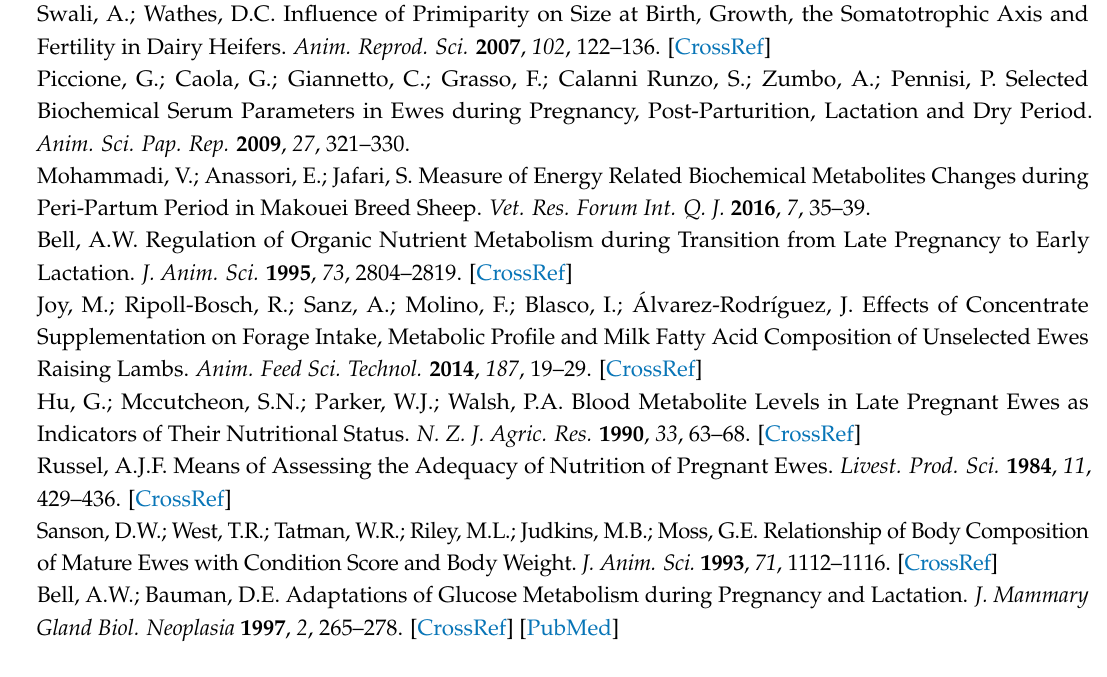
Figure S7 : Concentrations of non-esterified fatty acids (NEFA) in plasma (mmol/l) in all ewes (left panels column, a, d, g, and j), mature ewes (central panels column, b, e, h, and k), and maiden sheep (right panels column, c, f, i, and l) throughout the study period. Sheep were classified by pregnancy rank (single: ; multiple: (cid:3) ; top row of panels a, b, and c) and by level of BCS measured at mid-pregnancy (BCS-1, second row of panels d, e, and f), at late (cid:35) pregnancy (BCS-2; third row of panels g, h, and i), and postpartum (BCS-3; bottom row of panels j, k, and l). BCS levels were “Thin” ( (cid:72) ) for sheep with a BCS ≤ 2, “Average” ( (cid:7) ) for sheep with 2 < BCS < 3, and “Fat” ( (cid:78) ) for sheep with a BCS ≥ 3. Data are mean ± S.E.M. When significant, the interactions of time × pregnancy rank or time × BCS level are represented in each panel by an upper horizontal line and capital letters indicating significance level (A: p < 0.0001; B: p < 0.001; b: tendency). Asterisks indicate significant differences between groups at each time point (**** p < 0.0001; *** p < 0.001; ** p < 0.01; * p < 0.05). Figure S8 : Plasma urea concentration (mg/dl) in all ewes (left panels column, a, d, g, and j), mature ewes (central panels column, b, e, h, and k), and maiden sheep (right panels column, c, f, i, and l) throughout the study period. Sheep were classified by pregnancy rank (single: ; multiple: (cid:3) ; top row of panels a, b, and c) and by level of BCS measured at mid-pregnancy (BCS-1, second row of (cid:35) panels d, e, and f), at late pregnancy (BCS-2; third row of panels g, h, and i), and postpartum (BCS-3; bottom row of panels j, k, and l). BCS levels were “Thin” ( (cid:72) ) for sheep with a BCS ≤ 2, “Average” ( (cid:7) ) for sheep with 2 < BCS < 3, and “Fat” ( (cid:78) ) for sheep with a BCS ≥ 3. When significant, the interactions of time × pregnancy rank or time × BCS level are represented in each panel with an upper horizontal line and capital letters indicating significance level (A: p < 0.0001; B: p < 0.001; C: p < 0.05; c: tendency). Asterisks indicate significant differences between groups at each time point (**** p < 0.0001; *** p < 0.001; ** p < 0.01; * p < 0.05). Table S1 : Morphometric measurements and metabolic status of lambs, stratified by maternal age and pregnancy rank. Table S2 : Morphometric measurements and metabolic status of lambs, stratified by maternal BCS in mid- or late pregnancy. Table S3: Pearson correlation coefficients between lamb birth weight and maternal metabolic indices at mid-gestation, with mothers classified by maternal age, pregnancy rank, maternal BCS at mid-pregnancy, and BCS in late pregnancy. Table S4: Pearson correlation coefficients between lamb birth weight and maternal metabolic indices in late gestation, with mothers classified by maternal age, pregnancy rank, maternal BCS at mid-pregnancy, and BCS in late